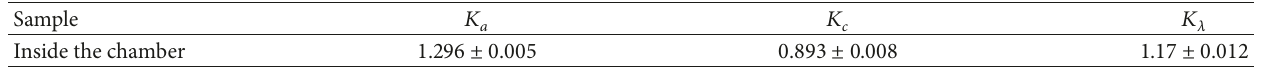
Table 7: Results of determining correction coefficients.